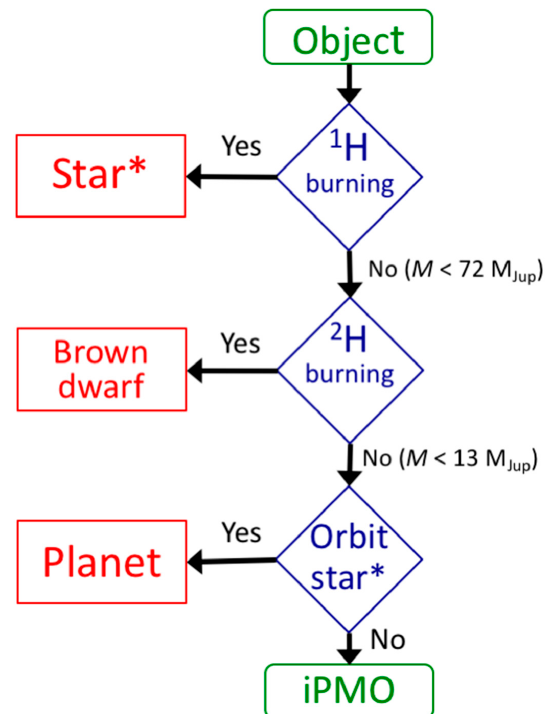
Figure 2. Flowchart of the Working Group on Extrasolar Planets position statement on the definition of a planet (1 M sol = 1047.6 M Jup ). The acronym iPMO stands for “isolated planetary-mass object”, but it can be replaced by “sub-brown dwarf (or whatever name is most appropriate)”. The asterisks of stars indicate that some of them also burn helium and more massive isotopes, and that planets orbit stars, white dwarfs, neutron stars or black holes. Image courtesy of the author.